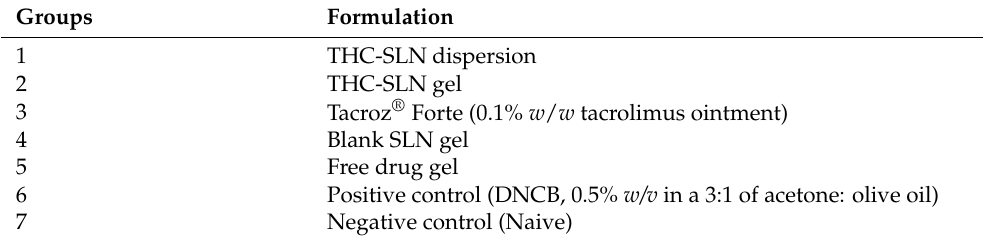
Table 1. Various groups along with their treatments for the pharmacodynamic study in murine a atopic dermatitis